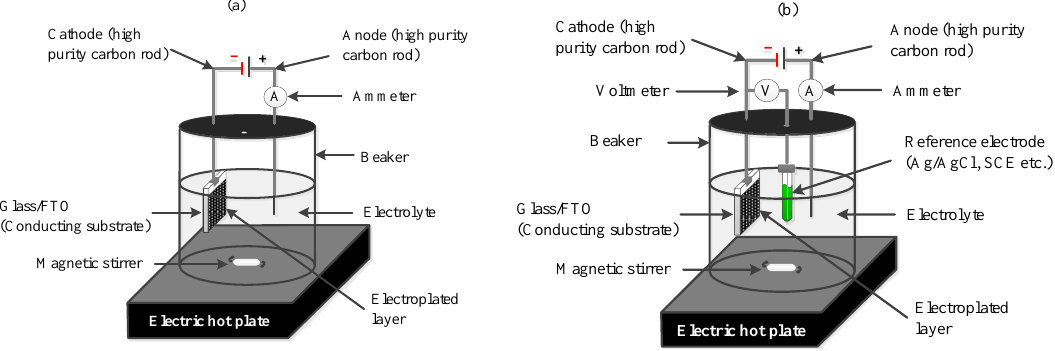
Figure 2. Typical ( a ) two-electrode and ( b ) three-electrode electrodeposition setups.